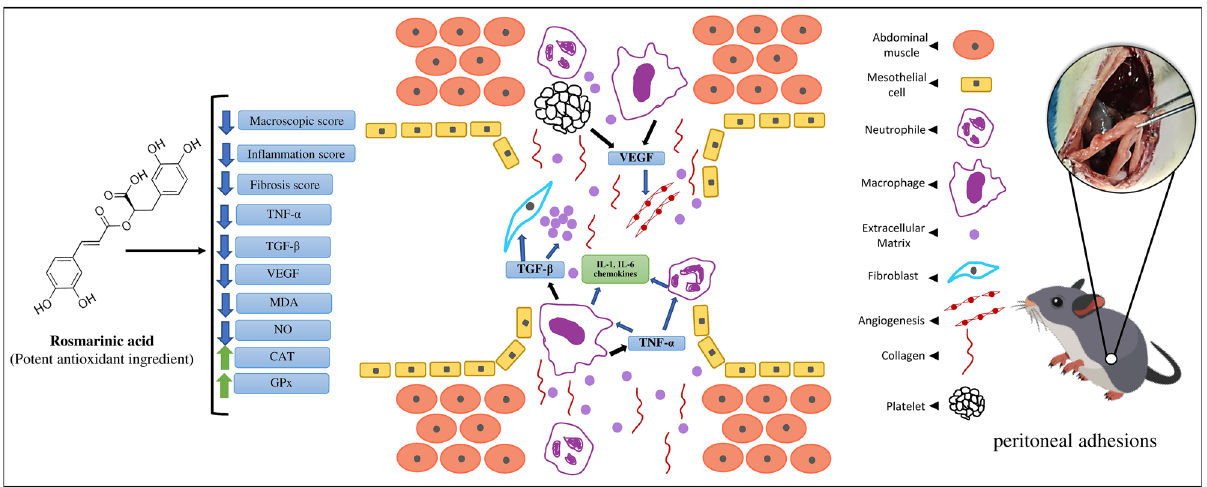
Figure 6. Rosmarinic acid reduced the development of postoperative intra-abdominal adhesion. Rosmarinic acid decreased inflammation, fibroblast proliferation, and inflammatory cytokines such as TGF-β1, TNF-α, and VEGF. Moreover, rosmarinic acid reduced oxidative stress. As a result, collagen deposition, angiogenesis, secretion of extracellular matrix (ECM), and fibroblast production are reduced, which are all involved mechanisms in adhesion